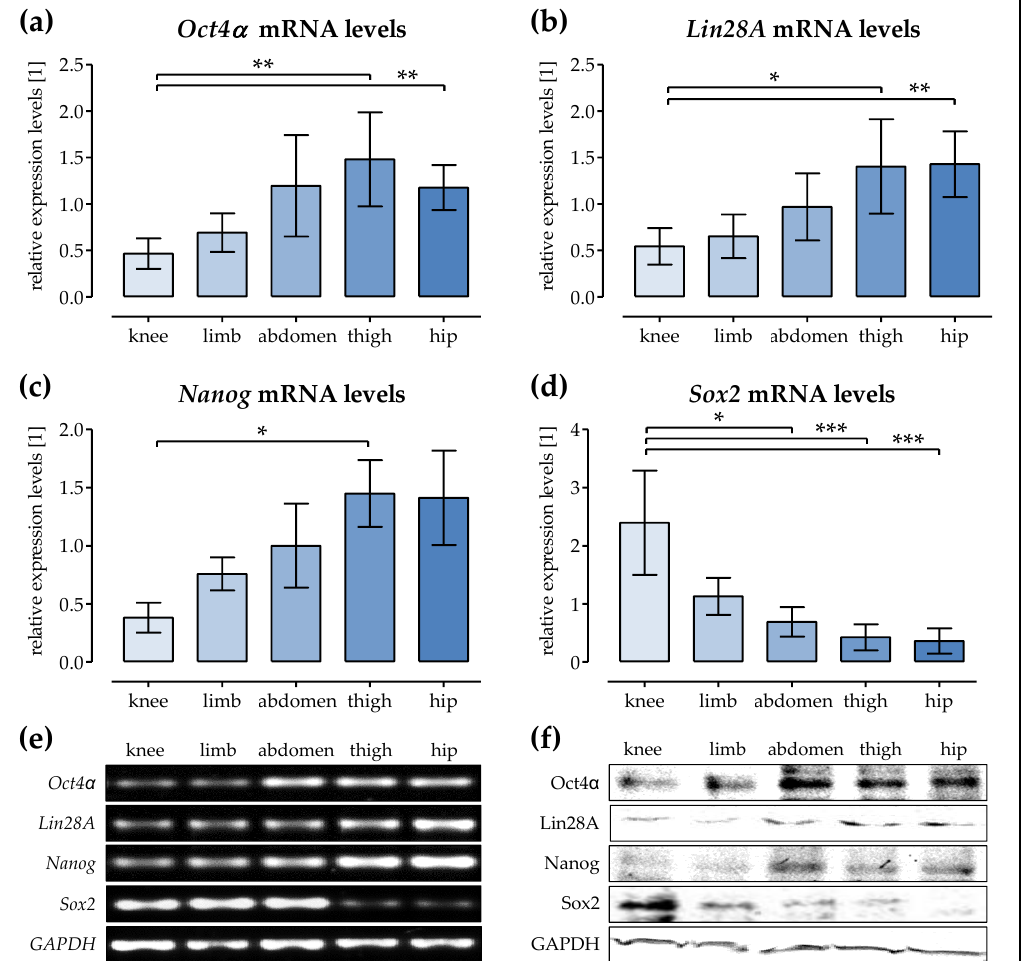
Figure 5. The expression of stem cell factors in Ad-MSCs varies depending on the donor site. The expression levels of the stem cell factors ( a ) Oct4 α , ( b ) Lin28A , ( c ) Nanog , and ( d ) Sox2 were determined by semi-quantitative RT-PCR in Ad-MSCs derived from adipose tissue of the knee, limb, abdomen, thigh, and hip ( N = 4 each). The PCR products were loaded twice ( n = 2) to minimize the loading errors. The signal intensities were quantified with the help of the ImageJ software. ( e ) Representative images for the RT-PCR products from the pooled samples; ( f ) Representative images for the Western blot signals obtained from the pooled samples; * p < 0.05, ** p < 0.01, and *** p < 0.001 as indicated.